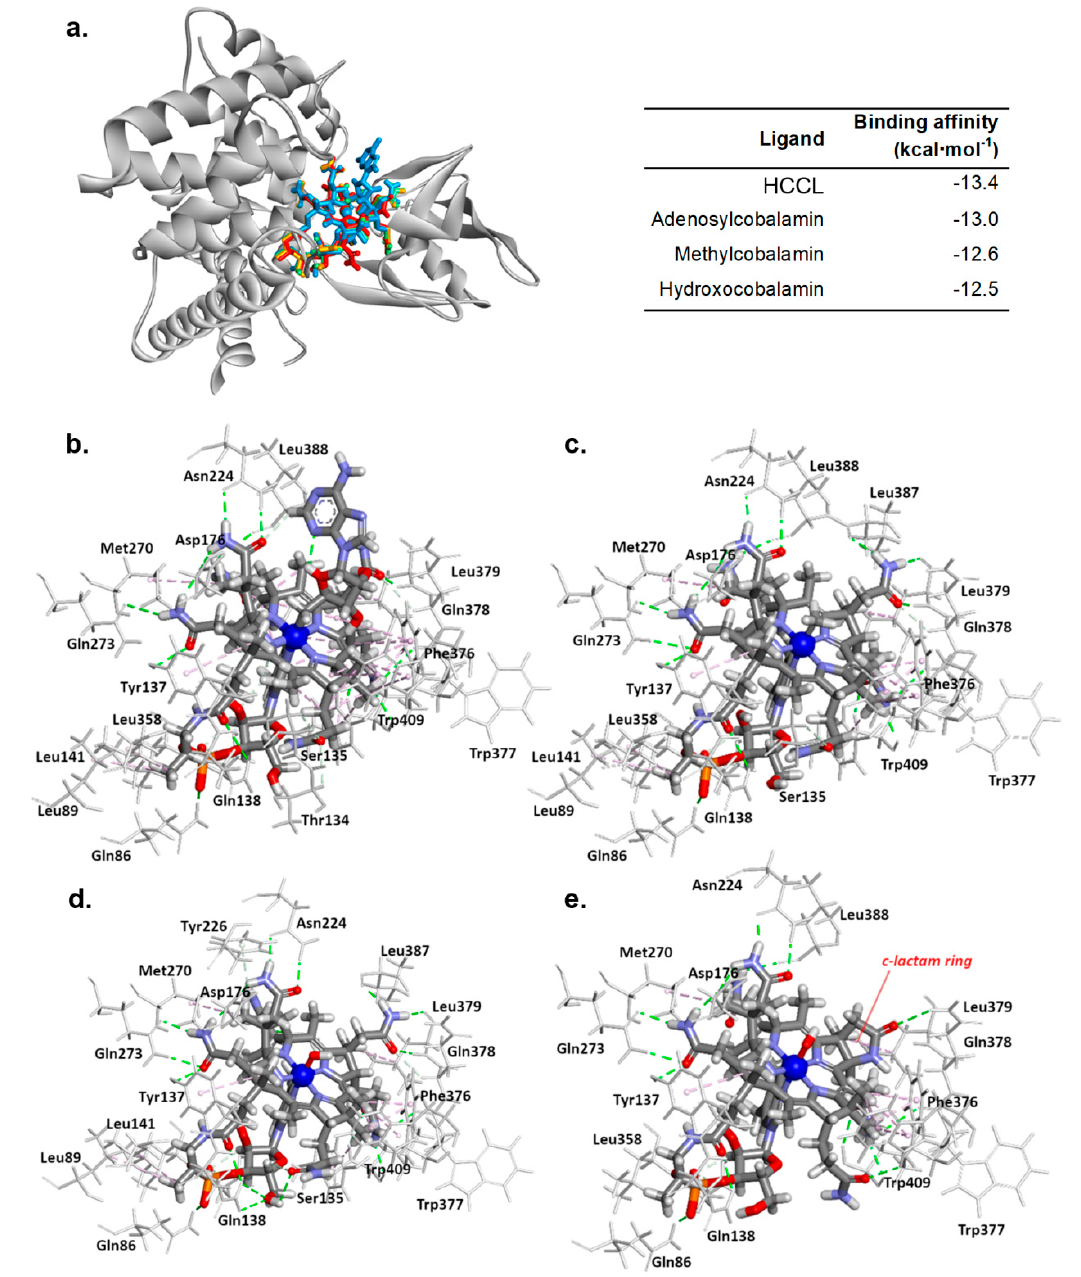
Figure 5. In silico molecular docking results. Docking pose of TCII protein complex with adenosylcobalamin (blue), methylcobalamin (green), hydroxocobalamin (orange), and HCCL (red)—left panel; binding parameters of transcobalamin II-ligand complexes—right panel ( a ). Predicted binding model of adenosylcobalamin ( b ), methylcobalamin ( c ), hydroxocobalamin ( d ), and HCCL ( e ) with transcobalamin II.